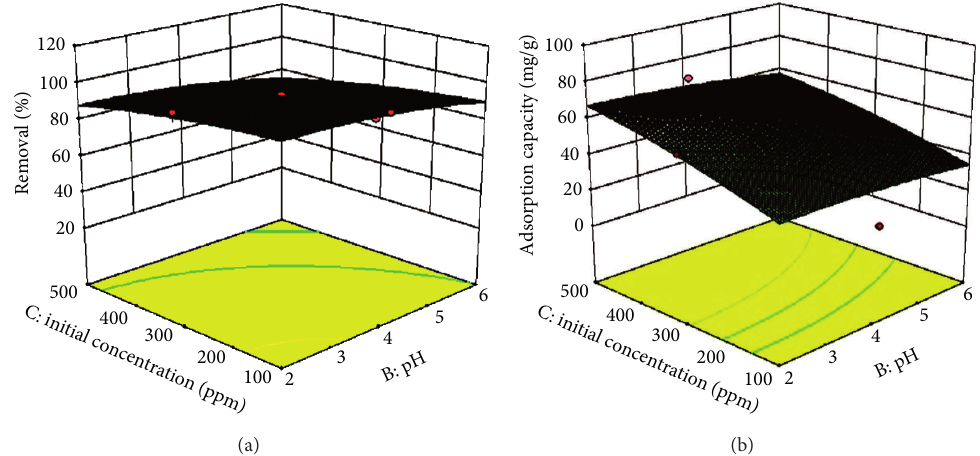
F 5: e combined effect of initial concentration and pH on (a) percentage removal and (b) adsorption capacity of Cr(VI) ions using